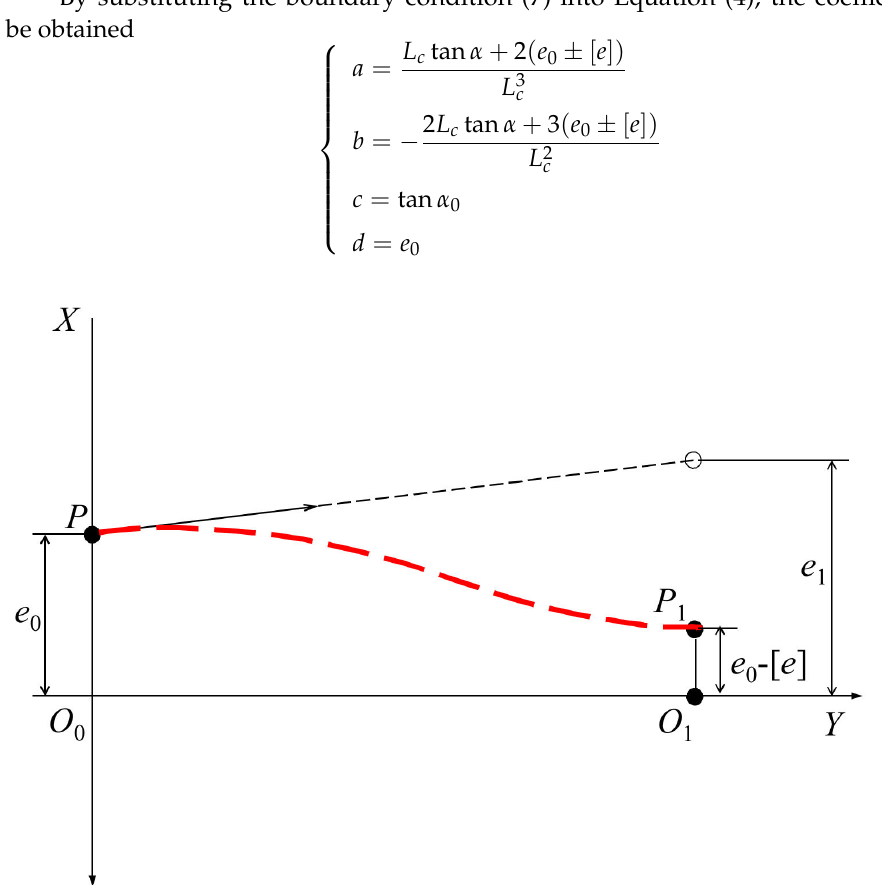
Figure 7. The cubic polynomial path when | e 1 | > | e 0 | and | e 0 | > [ e ]. The Bezier Curve